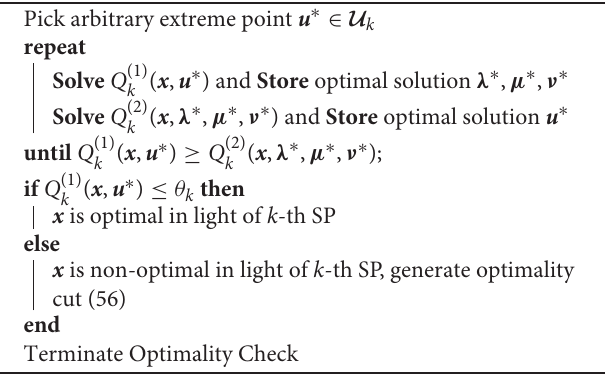
Algorithm 2: Optimality Check for k -th SP